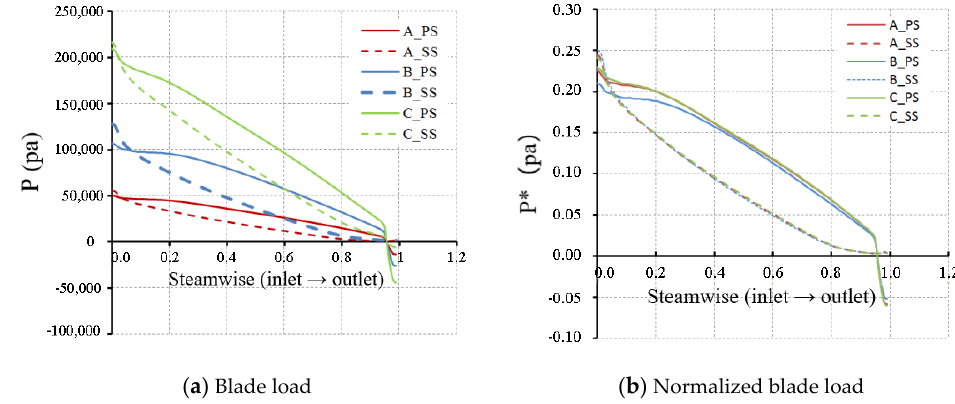
Figure 10. Blade load of various best efficiency points (BEPs). In this paper, the circumferential pressure variation (from PS to SS) in the impeller passages are monitored, as Figure 10 shows. The abscissa is the radial position of the run- ner (perpendicular to the streamline direction), and the ordinate is the pressure. On the whole, the pressure of the radial boundary decreases from the PS to SS, since the blade rotates and works. In theory, the pressure will drop uniformly if circumferential slip and vortex of the fluid are not taken into consideration. In Figure 11a, the curves have different pressure gradients in the blade inlet position. Obviously, the trend of working condition B is the closest to linearity, followed by C, and the deviation of A is the largest. The flow turning points takes place at the position a little larger than 0.4 L (L is the cross-section line), whereas the pressure drop on both sides is steep, and the flow field structure is dif- ferent, to a certain degree. Combined with the velocity contour above, it can be judged that there are always local vortexes of a certain scale on the inner side and a significant radial cross-flow on the outer side, with uneven distribution of radial flow and velocity. In Figure 11b, the transition point appears at 0.625 L, which indicates a migration of main- stream trajectory from PS to SS, compared with suction position. The pressure fluctuation of B and C after the transition point may result from the flow deflection of upstream di- rection since there is no obvious vortex, while the pressure drop of B under the same con- dition is closer to the trend line, indicating a more uniform flow structure. To be noted, the pressure drop range varies from 0.86 to 0.55 in the inlet position, and that shrinks to 0.34~0.41; the radial gradient of inlet position is much larger than the middle position.